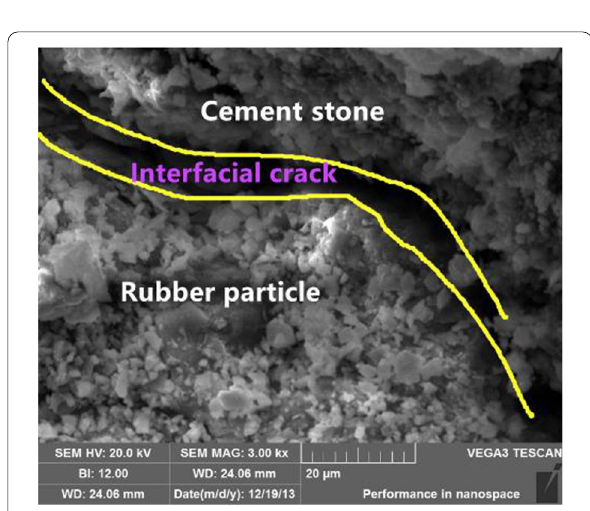
Fig. 7 Bonding of RPs to cement